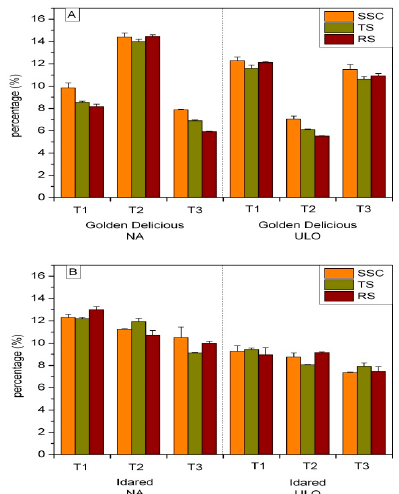
Figure 2. Impact of storage type on soluble solids content (SSC), total sugars (TS), and reducing sugars (RS) content expressed in percentage (%) in ( A ) ‘Golden Delicious’ and ( B ) ‘Idared’ apples after 10 (T2) and 20 days (T3) of shelf life at 20 ◦ C. Values represent mean ± standard deviation (S.D.) of three replicates per storage type and shelf life